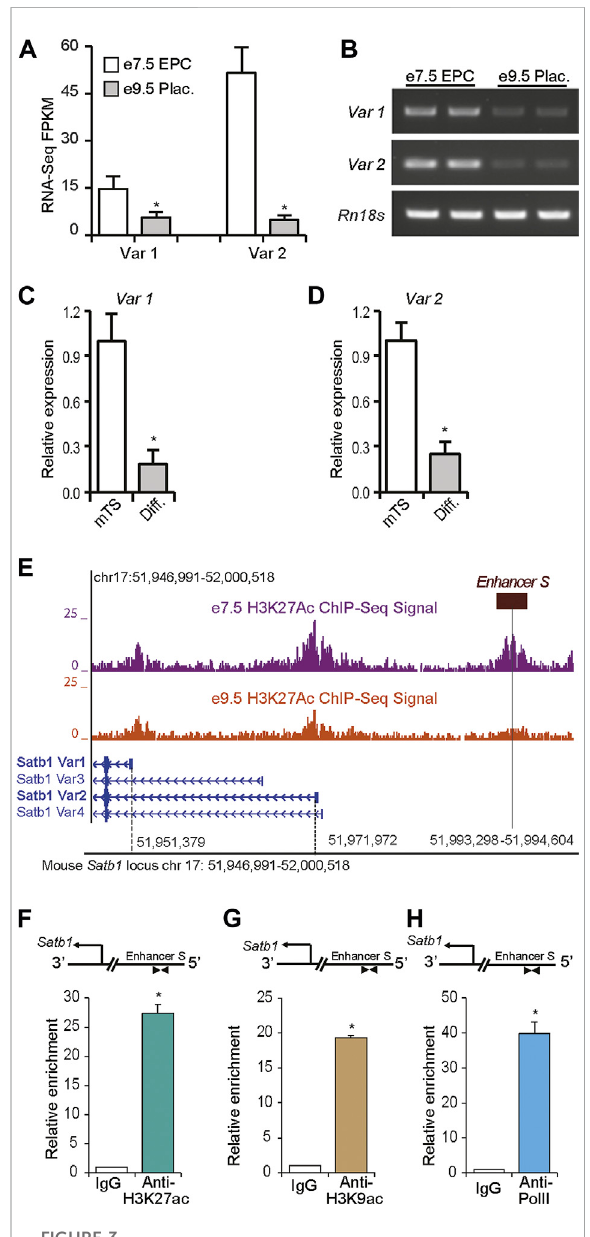
Table S4. RNA-seq FPKM, RT-qPCR, and ChIP-qPCR data are expressed as mean ± S.D. * p < 0.05 ( n = 3). EPC, ectoplacental cone; Plac.,